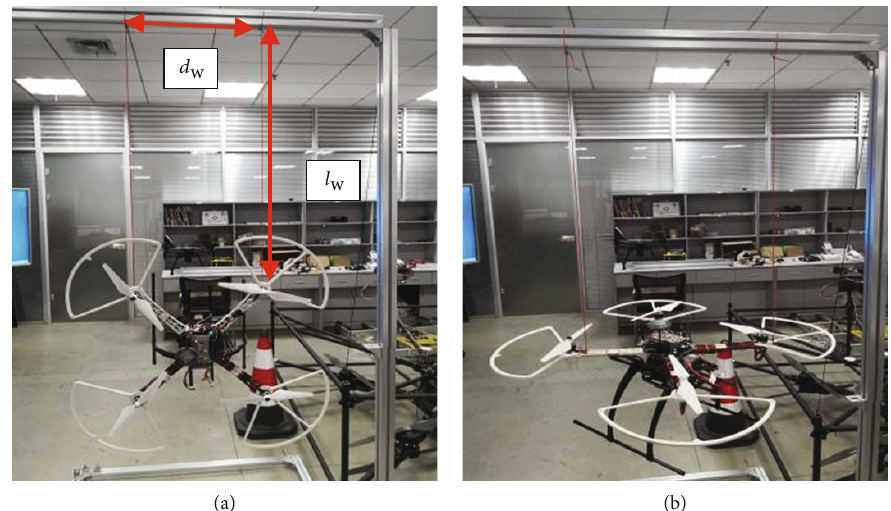
Figure 4: Bi fi lar pendulum setup for the estimation of the moments of inertia of the quadrotor: (a) J